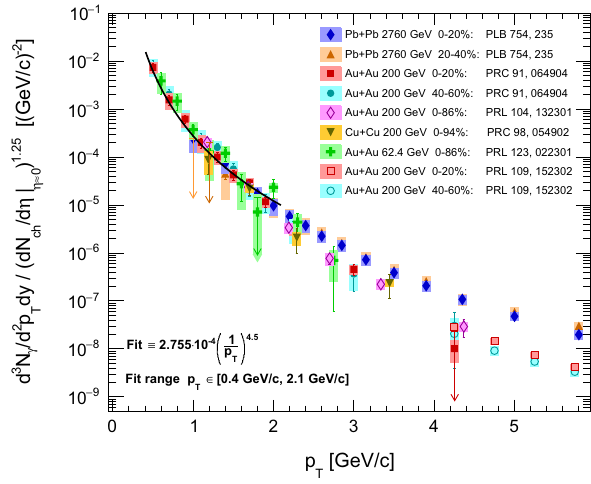
Fig. 1 Direct photon invariant yield as a function of p T for various colliding nuclei and collision centrality selections at three center-of- mass energies. The plot labels give the references of the shown data. The vertical lines of the data points describe statistical uncertainties, the boxes describe systematic uncertainties